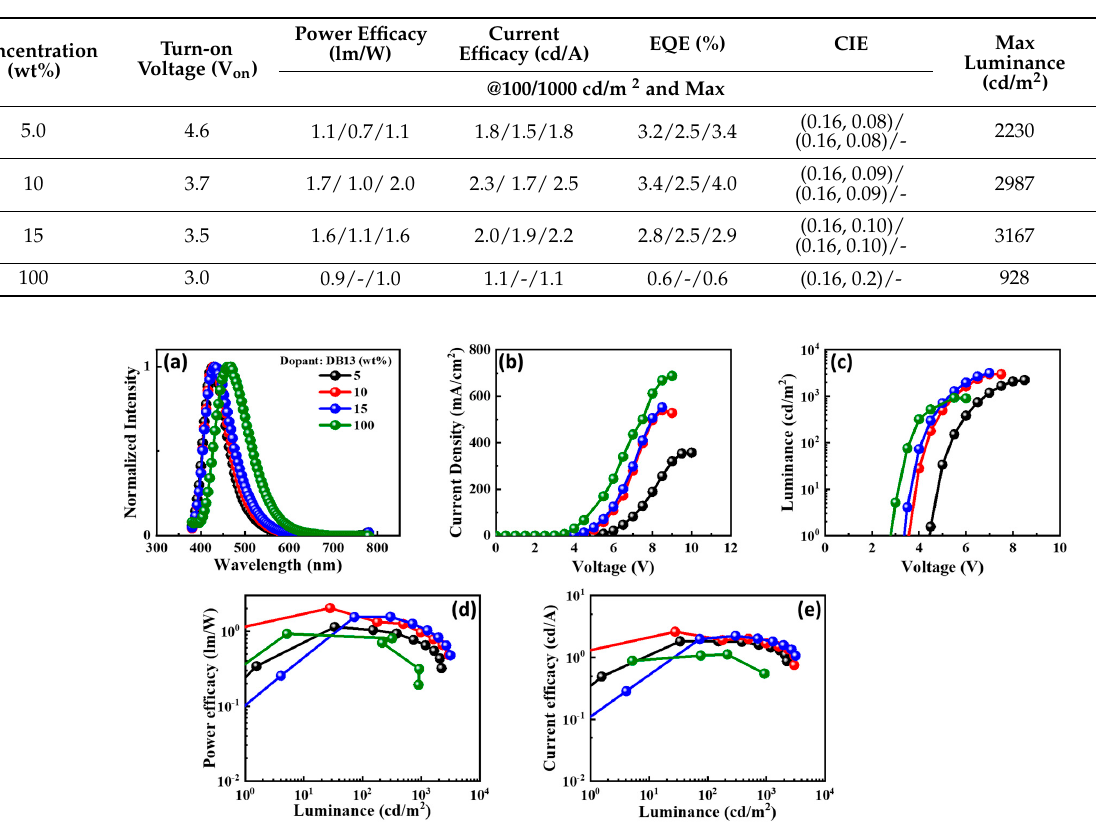
Figure 12. The electroluminescent (EL) properties of the device with emitter DB13 doped in CBP host matrix at varying concentrations showing ( a ) EL spectra, ( b ) current density–voltage, ( c ) luminance– voltage, ( d ) power efficacy–luminance, and ( e ) current efficacy–luminance characteristics.